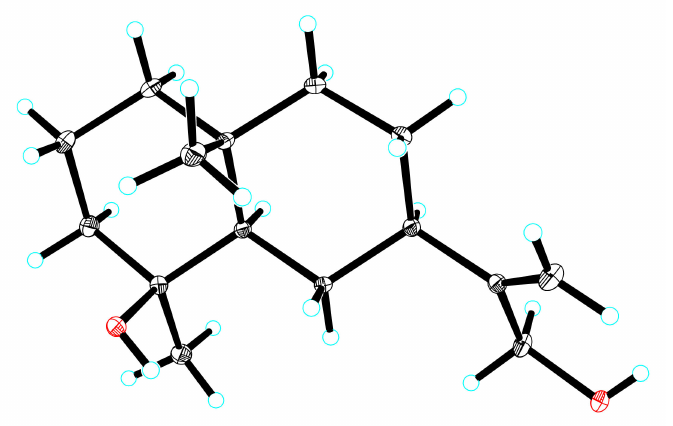
Figure 6. Single crystal X-ray structure of Compound 2 .